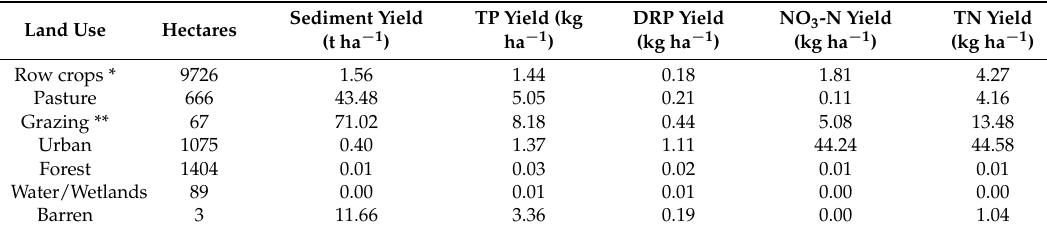
Figure 11. Average surface runoff and sediment and nutrient yields by scenario and subbasin, Eagle Creek watershed, Ohio. Table 9. Average annual yields by land use in the All Contracted scenario investigated with the Eagle Creek watershed, Ohio SWAT model.